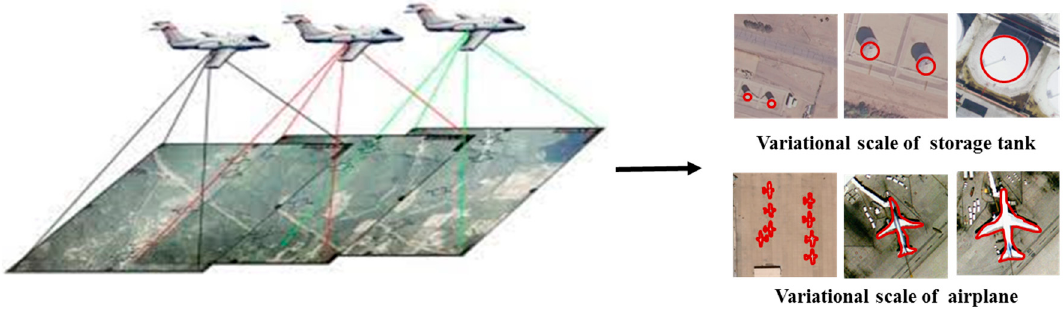
Figure 1. An example of object scale variation that may be caused by sensor altitude or angle variation.